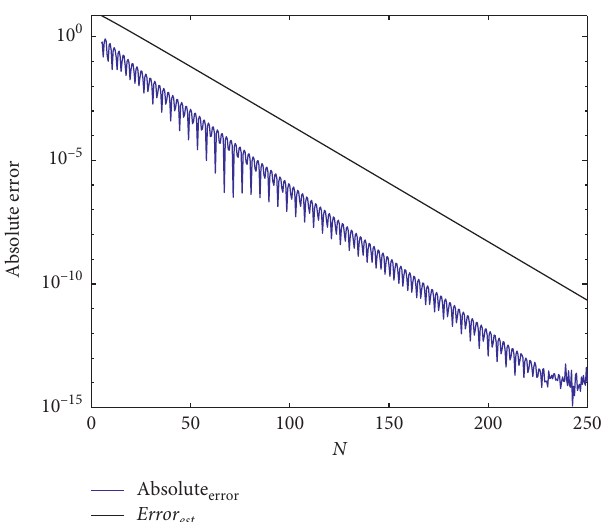
Figure 5: The comparison between absolute error and error